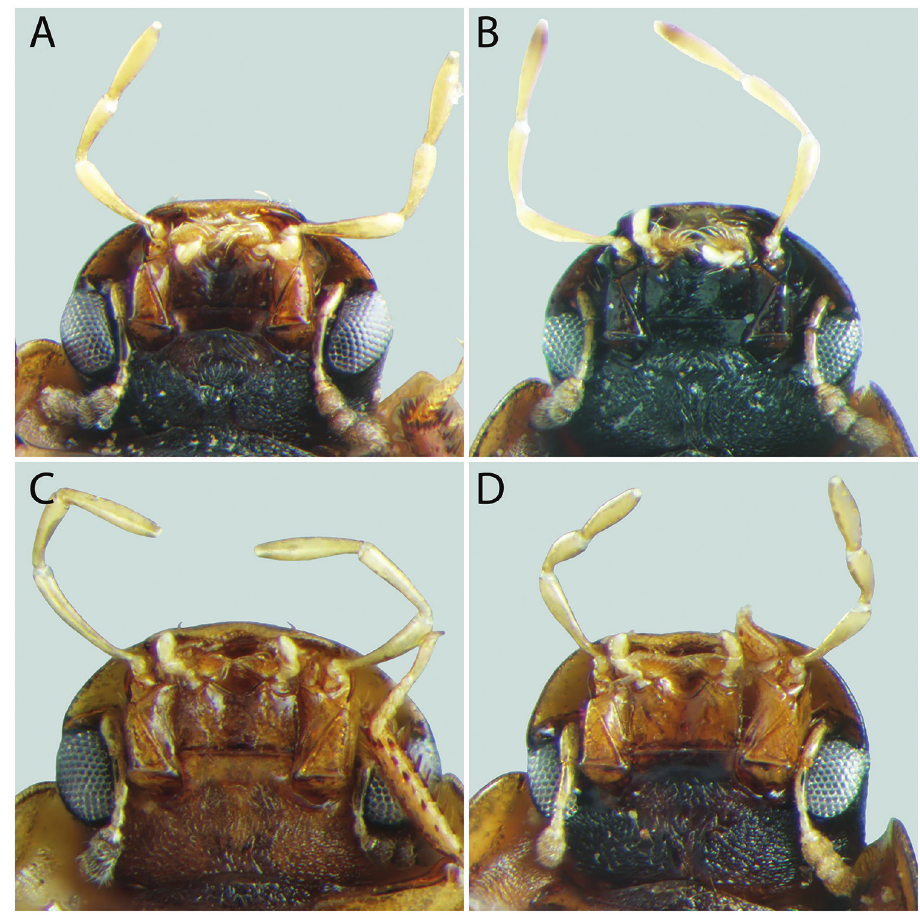
sp. n. D T. canthus sp.